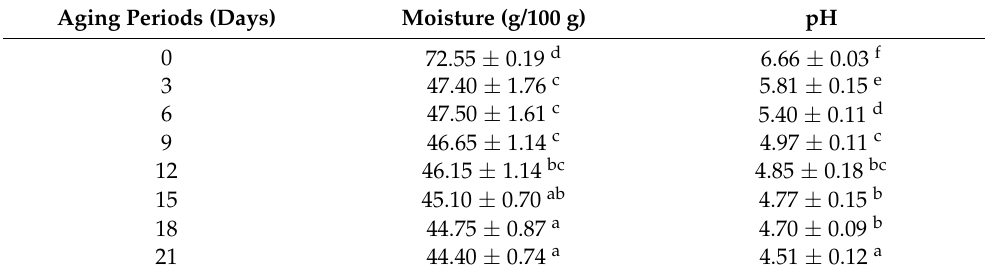
Table 1. Changes in moisture content and pH in BG made from SRG during the aging period. Aging Periods (Days)